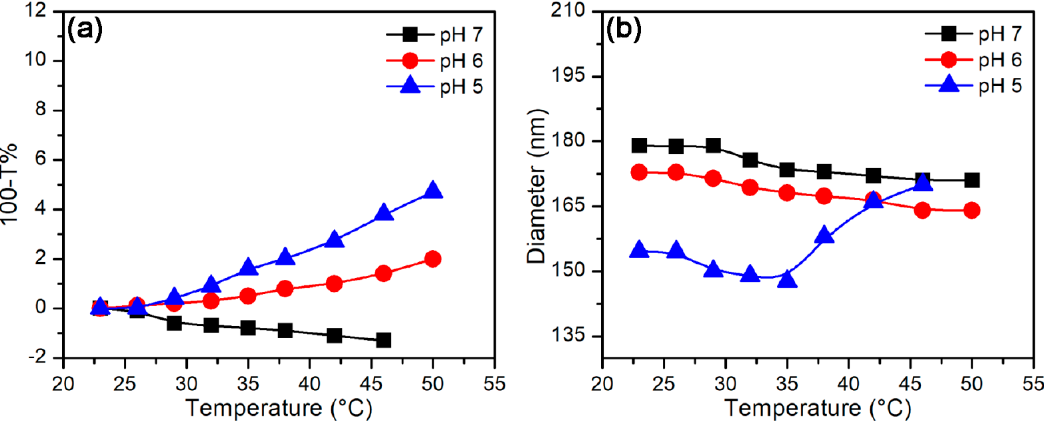
Figure 8. Effect of temperature on protein adsorption in PSV@PAA- b -PNIPA at various pH values via ( a ) turbidity and ( b ) hydrodynamic diameter change.